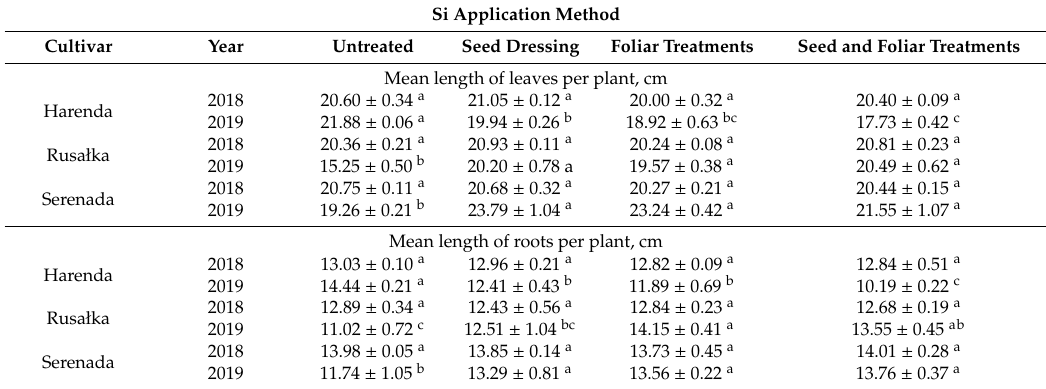
Table 3. Growth parameters of common wheat plants evaluated in the BBCH 29 growth stage depending on di ff erent methods of Si application.